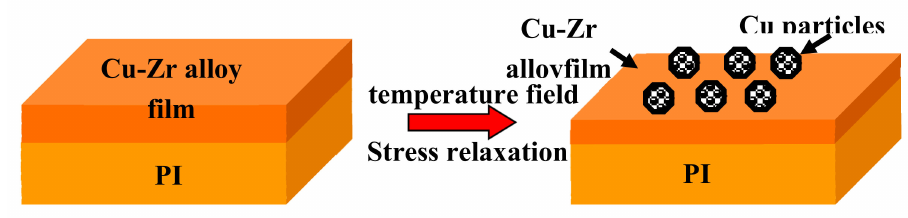
Figure 13. Schematic diagram of Cu particle formation on the annealed Cu–Zr alloy film’s